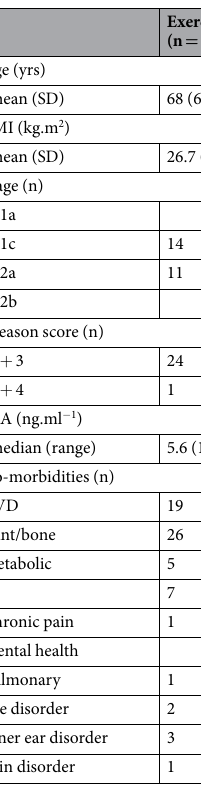
Table 1. Baseline characteristics of men enrolled in the PANTERA